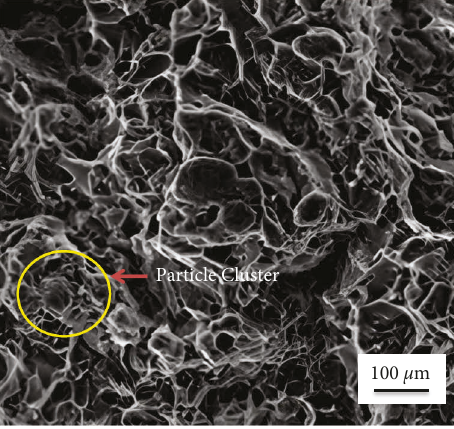
Figure 14: SEM fracture image of sample-L13